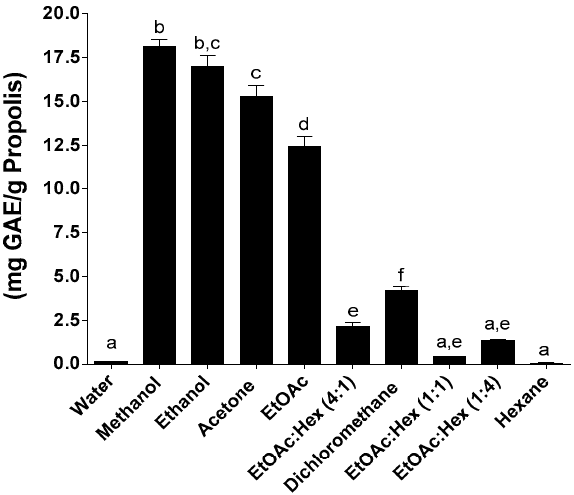
Figure 1. Total phenolic content following SE. Values are the means ± SEM of at least three independent experiments, each performed in duplicate; values with different superscripts are significantly different ( p < 0.05) as determined by one-way ANOVA test with subsequent Tukey’s adjustment; GAE: gallic acid equivalent.